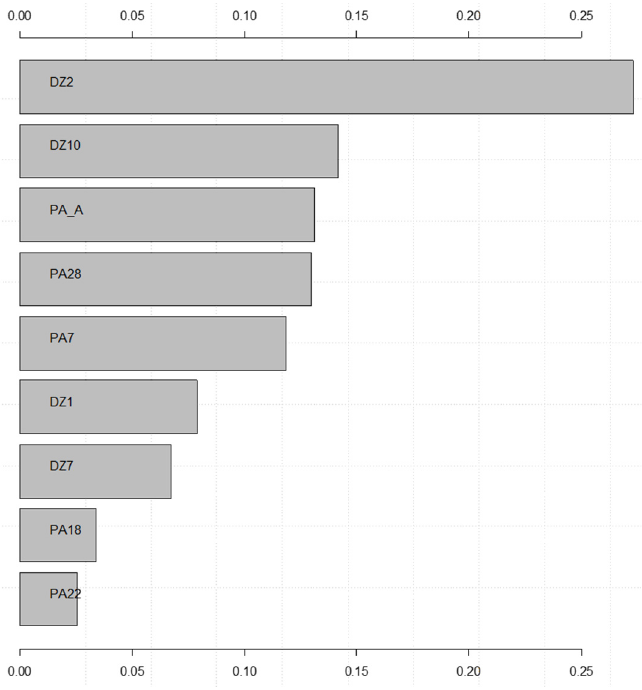
Figure 2. Importance of variable of final model “aggression” vs. “no aggression”: DZ2 = patient showed negative behavior toward other patients; DZ10 = patient broke ward rules; PA_A = PANSS score at admission; PA28 = Adapted PANSS at admission: poor impulse control; PA7 = Adapted PANSS at admission: hostility; DZ1 = patient complained about the hospital staff; DZ7 = Patient showed dis/antisocial utterances or attitudes; PA18 = Adapted PANSS at admission: tension; PA22 = Adapted PANSS at admission: uncooperativeness .